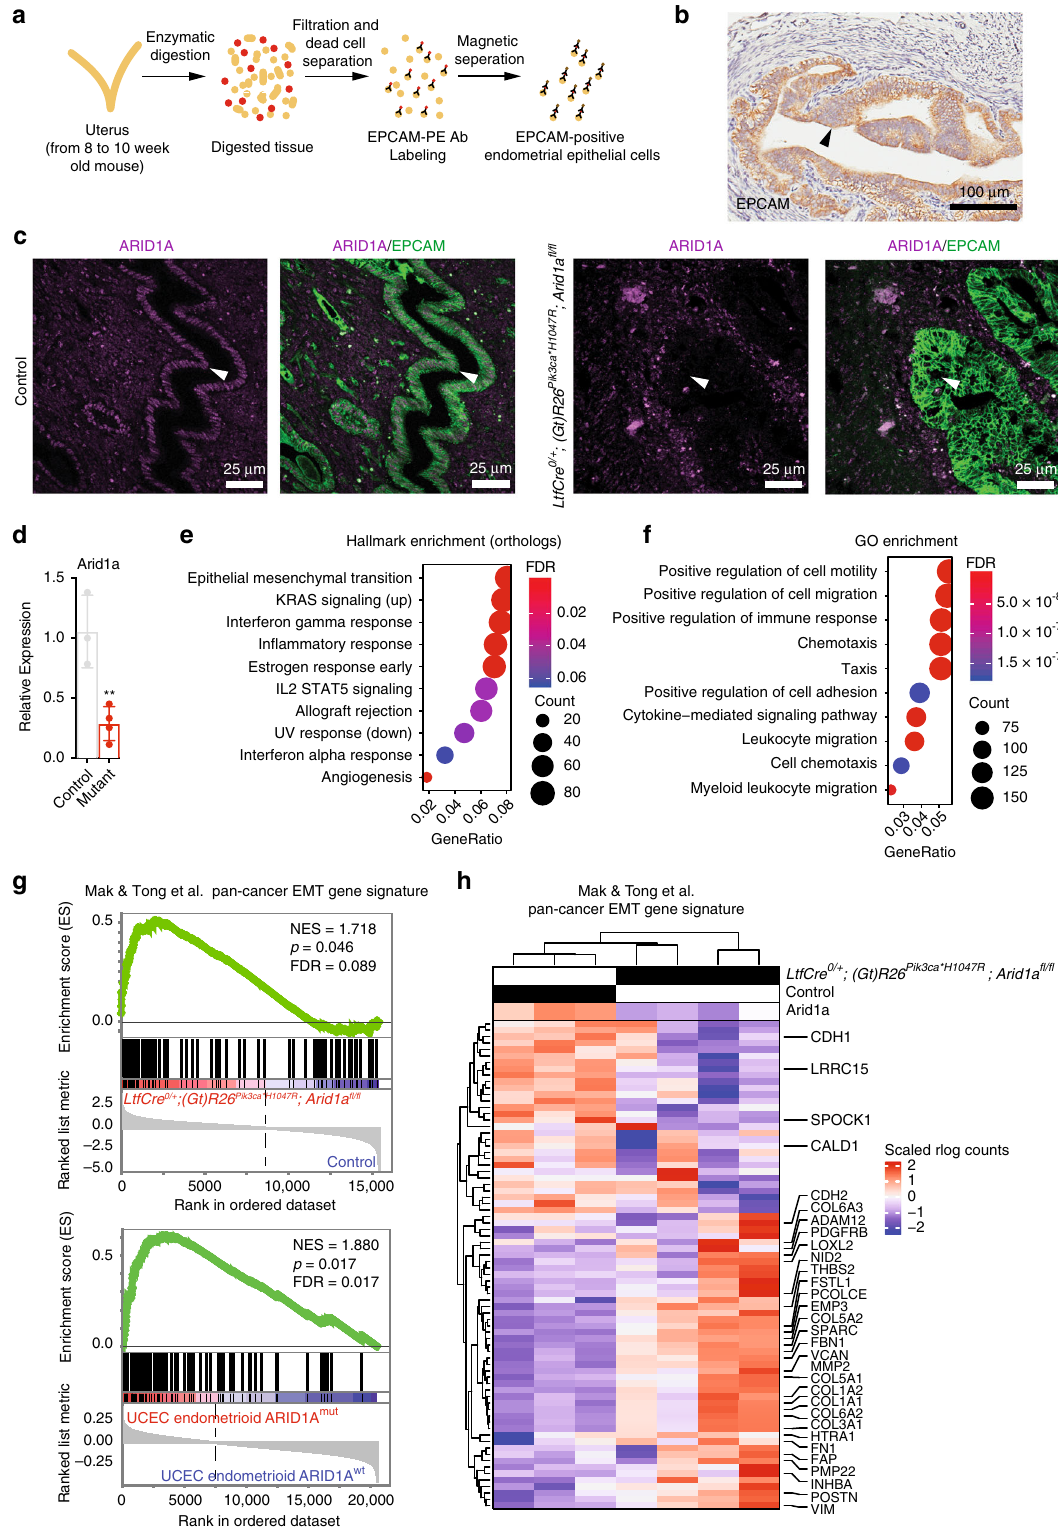
(Fig. 4g). Differentially accessible peaks, including